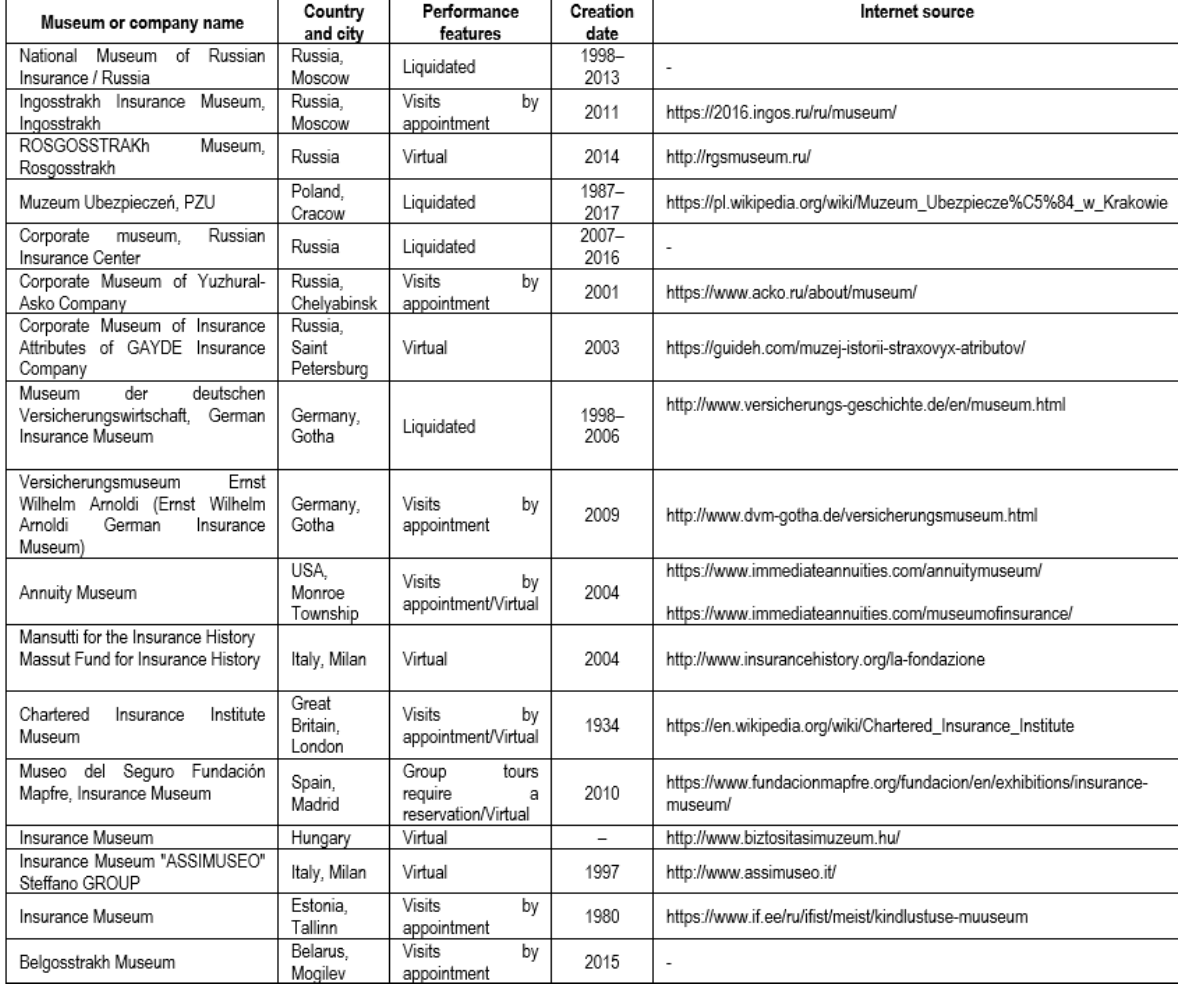
Table 2. Insurance museums in different